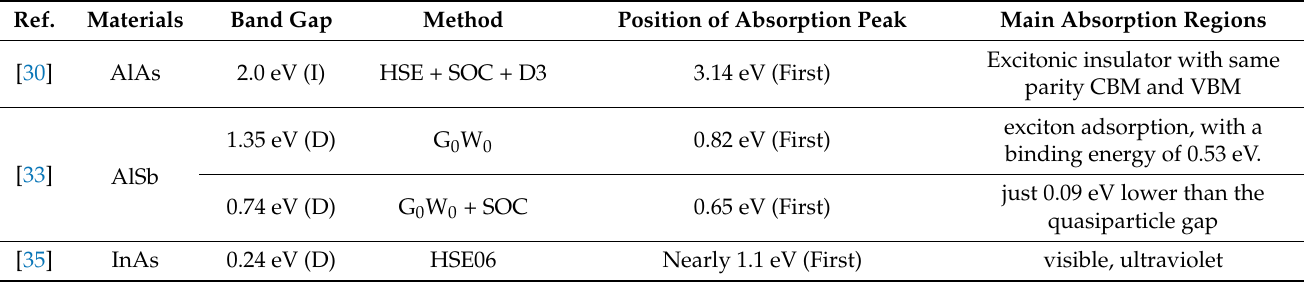
Table 2. Calculated optical absorption properties of DLHC materials. “I” and “D” are for indirect and direct band-gap semiconductors,